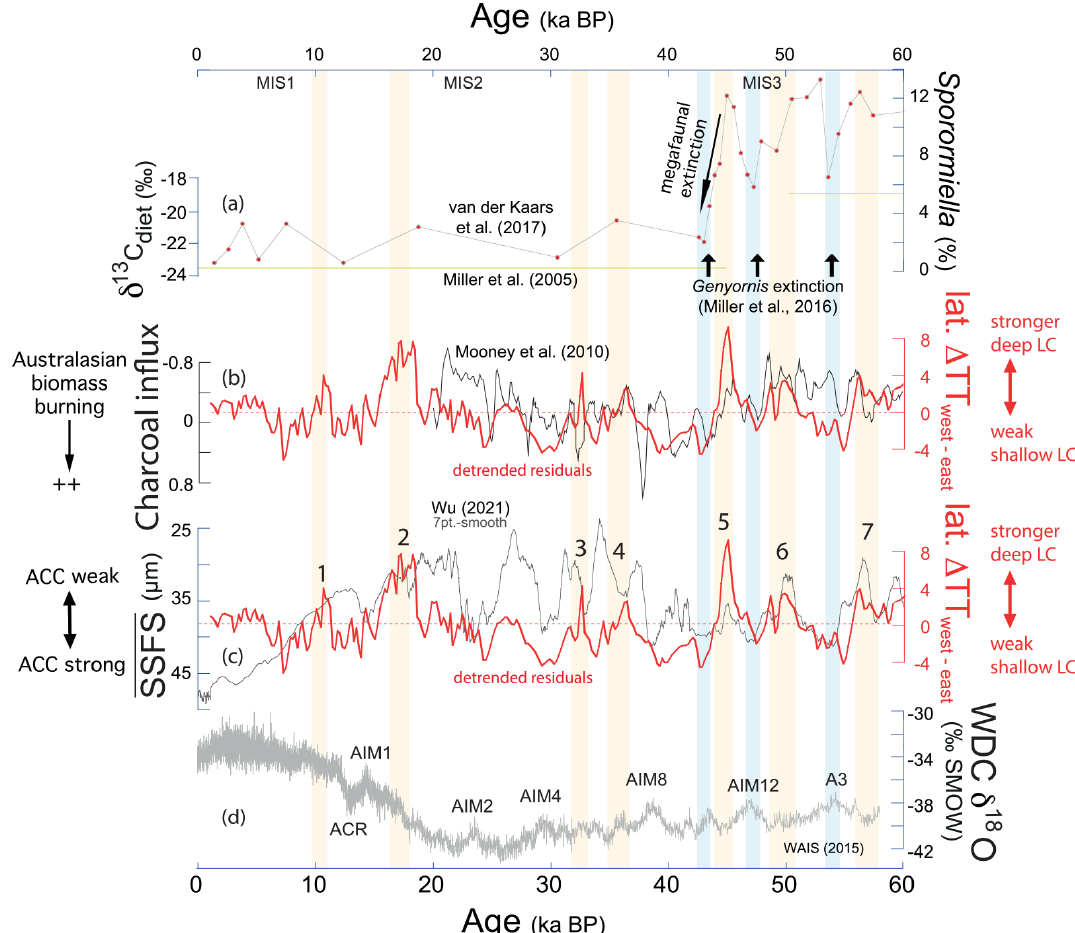
Figure 8. Variability of Leeuwin Current strength in comparison to Australian megafaunal extinction, biomass burning, and Antarctic Circumpolar Current (ACC) strength over the last 60kyr. (a) Record of dung fungus Sporormiella percentages in western core 2614, pointing to the Australian megafaunal population collapse at ∼ 45 to 43.1ka BP (van der Kaars et al., 2017). The yellow lines depict the Australian emu Dromaius dietary δ 13 C change documenting a permanent change in food sources (Miller et al., 2005). The three black arrows indicate most probable extinction dates of the Australian megafaunal bird Genyornis newtoni at ∼ 54, ∼ 47, and ∼ 43ka BP (Miller et al., 2016). (b) Residuals of detrended lateral (west–east) temperature gradients at thermocline depth reflecting Leeuwin Current strength (red; detrended with Past4 software; https://www.nhm.uio.no/english/research/resources/past/, last access: 10 November 2022), underlain by the Mooney et al. (2010) record of Australian biomass burning. (c) Residuals of detrended lateral (west–east) temperature gradients at thermocline depth reflecting Leeuwin Current strength (red), underlain by the sortable silt record (SSFS; 7pt-smooth) of Drake Passage sediment core PS97-85 reflecting the strength variability of the ACC (Wu et al., 2021). (d) West Antarctic Ice Sheet Divide Core δ 18 O record (WAIS Divide Project Members, 2015) as a reference for the Southern Hemisphere climate signal. Orange shading shows short time periods of a strong Leeuwin Current, mostly accompanied by less Australian biomass burning and ACC weakening. Blue shading shows an Antarctic warming event (A3) and Antarctic Isotope Maxima (AIM 12, 10). MIS stands for Marine Isotope Stages 1–3. ACR stands for Antarctic Cold